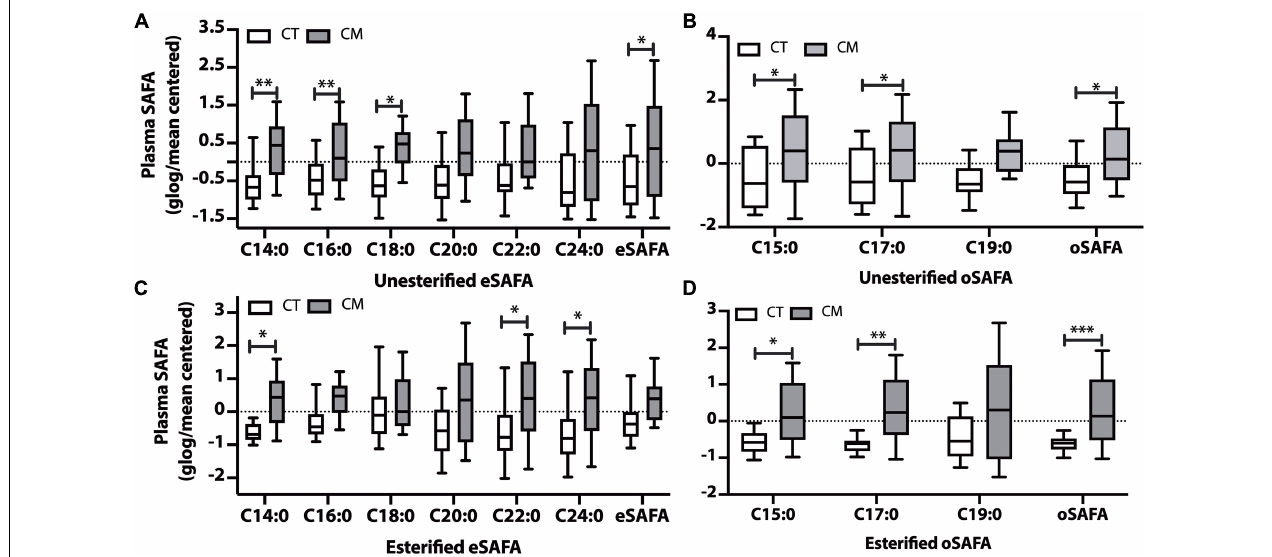
FIGURE 2 | Saturated fatty acid (SAFA) changes in plasma of CT and CM. Box and Whisker plots of unesterified even chain SAFAs (eSAFA) (A) , unesterified odd chain SAFAs (oSAFAs) (B) , esterified eSAFAs (C) , and esterified oSAFAs (D) . Fatty acid levels (ng/mL) were normalized using globalized logarithmic transformation and mean-centered. Unpaired multiple t -tests with correction for multiple comparisons (False Discovery Rate, FDR) using the two-state step-up method (Benjamini, Krieger, and Yekutieli). ∗ denote adjusted p ( q ) < 0.05, ∗∗ p < 0.01, ∗∗∗ p < 0.005.